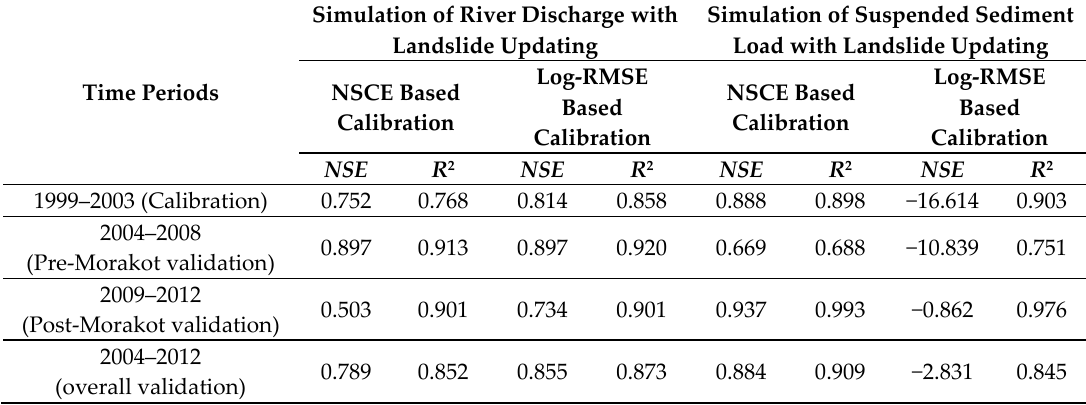
Figure 10. Comparisons between the simulated and observed flow rates in the calibration leftand validation) periods. Sub-figures ( a , b ) are the simulated results from the log-RMSE calibrated parameters; sub-figures ( c , d ) are the simulated results from the NSCE calibrated parameters. Table 5. Summary of the performance indicators for the SWAT modelling of river discharge and suspended sediment load during calibration and validation